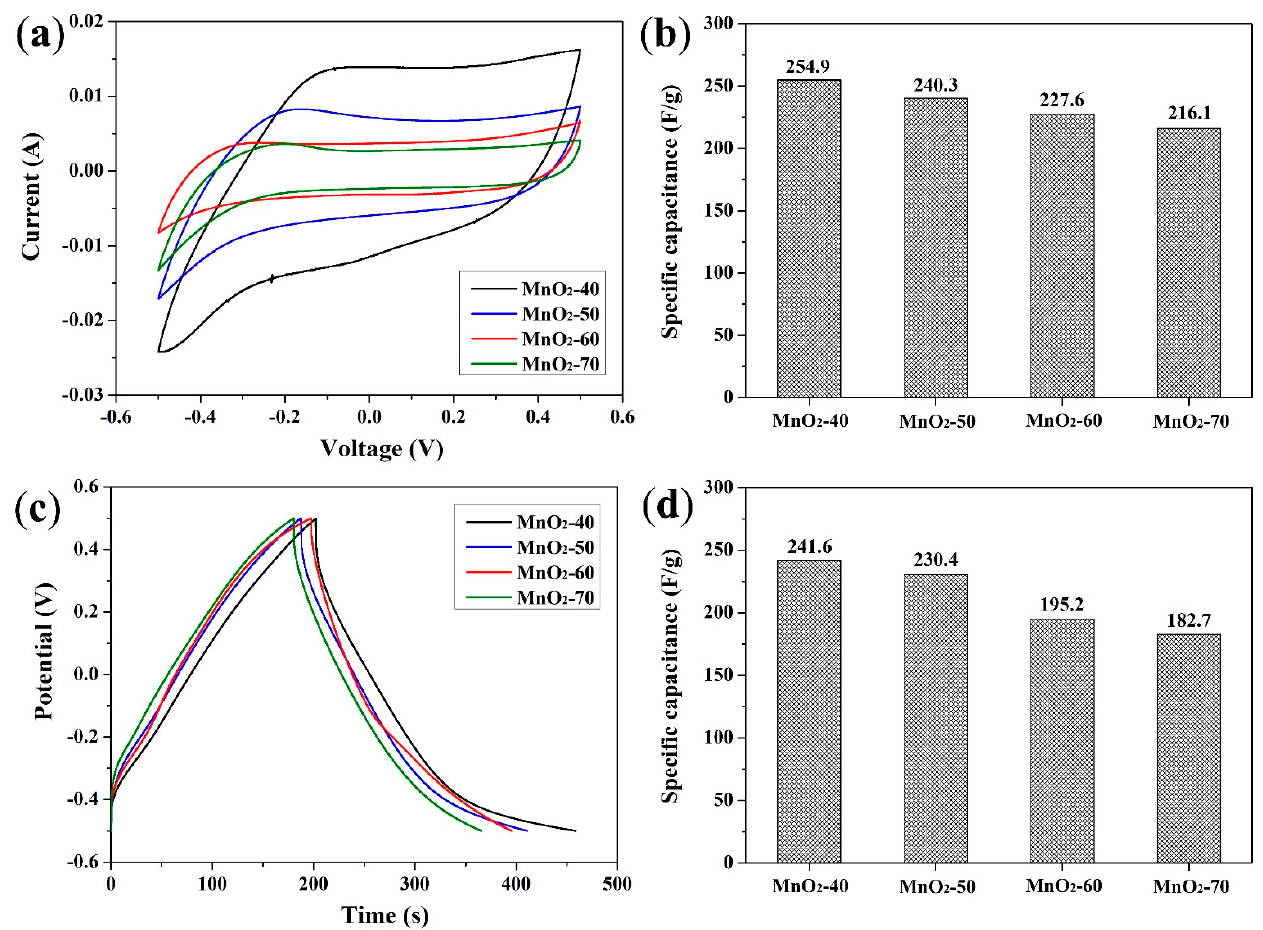
Figure 8. MnO 2 prepared at different temperature: ( a ) CV profiles at the scan rate of 5 mV/s, ( b ) the plot of specific capacitance at the scan rate of 5 mV/s, ( c ) GCD profiles at the current density of 1 A/g, ( d ) the plot of specific capacitance at current density of 1 A/g.